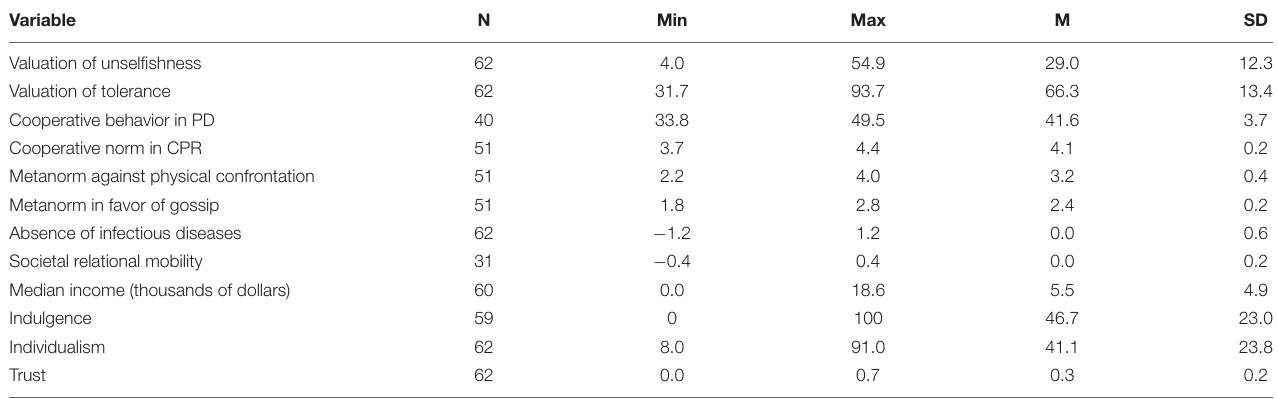
TABLE 1 | Descriptive statistics of key variables.